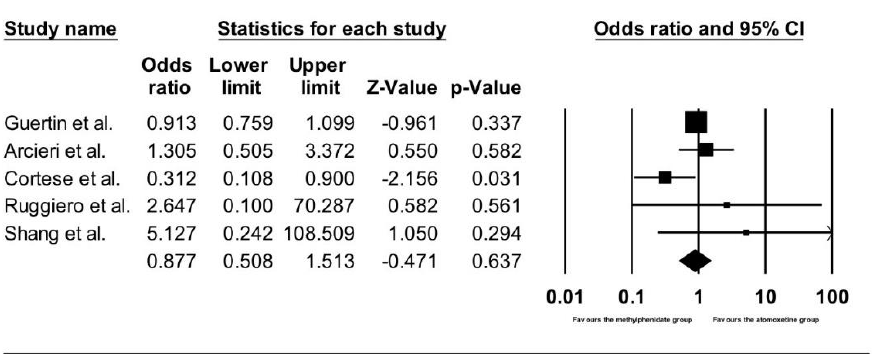
Figure 7. Forest plot on number of adverse cardiac events in children and adolescents receiving methylphenidate versus atomoxetine treatment.